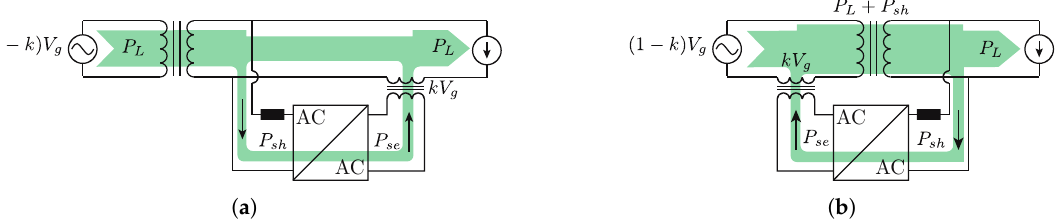
Figure 17. Circulating active power flow scenarios. ( a ) No circulating power between the LFT and the power converter. ( b ) Circulating power flow between the LFT and power